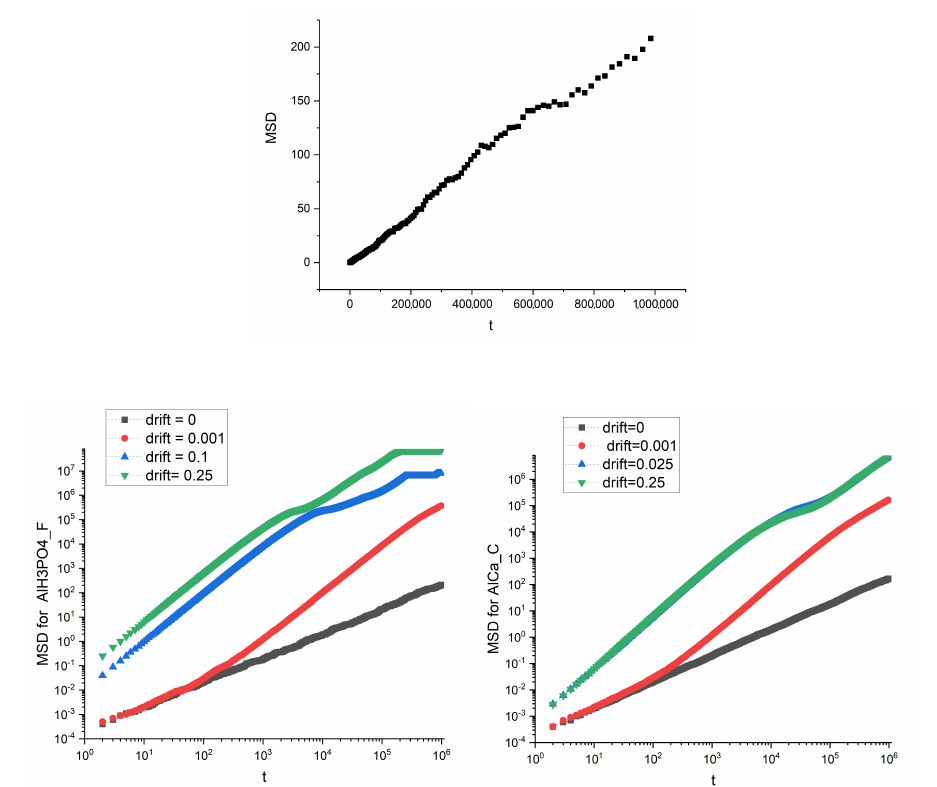
Figure 5. The mean square displacement dependence on time for the image of AlH 3 PO 4 _F membrane for Λ = 0 ( top panel ). Linear dependence of MSD on t denotes standard diffusion: α = 0. Bottom panel are for AlH 3 PO 4 _F membrane ( left ) and AlCa_C membrane ( right ) and various drifts. Log-log scale is used for convenience.